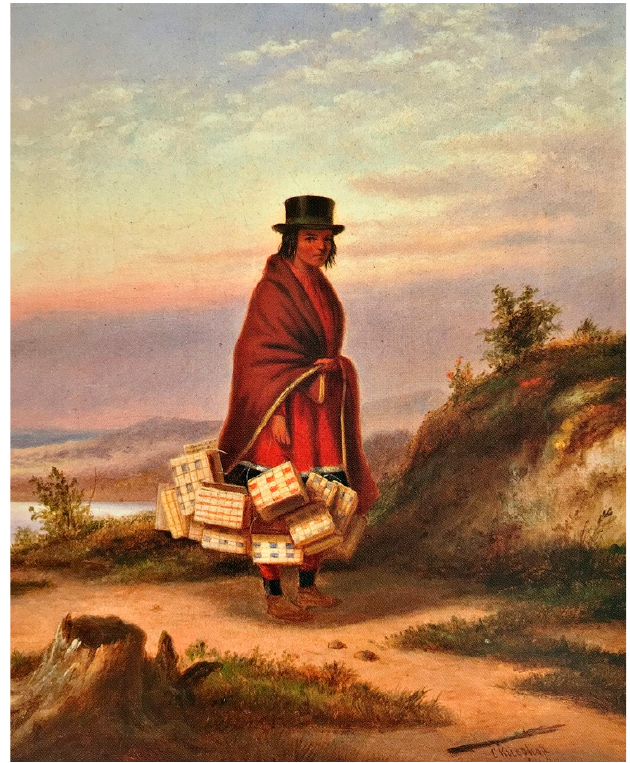
Figure 1. Cornelius Krieghoff, Basket Seller from Kahnawake , 1847–1852. Oil on canvas, the McCord Museum, Montreal, QC. https://www.musee-mccord.qc.ca/en/photographic-services-and-copyright/rates-for-photographic-reproductions/.